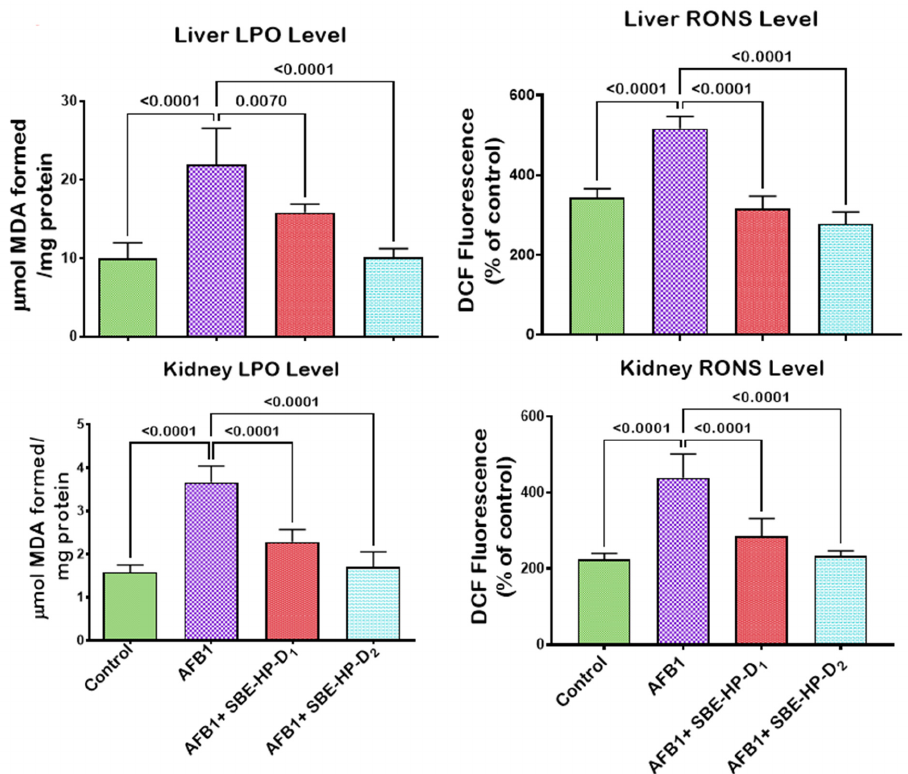
Figure 7. E ff ect of SBE-HP on the concentrations of LPO and RONS in the liver and kidney of rats treated with AFB 1 for 28 d. AFB 1 at 50 µg/kg; SBE-HP-D1 at 5 mg/kg; SBE-HP-D2 at 10 mg/kg. Values are expressed as mean ± SD for six rats per treatment cohort. Connecting lines indicate groups compared to one another. The signi fi cance level was set at (p < 0.05 ) ; p < 0.05 suggests the level of signi fi cance; p > 0.05: not signi fi cant. AFB 1 : A fl atoxin B1; D1: lower dose; D2: higher dose; LPO: Lipid peroxidation; RONS: Reactive oxygen and nitrogen species.